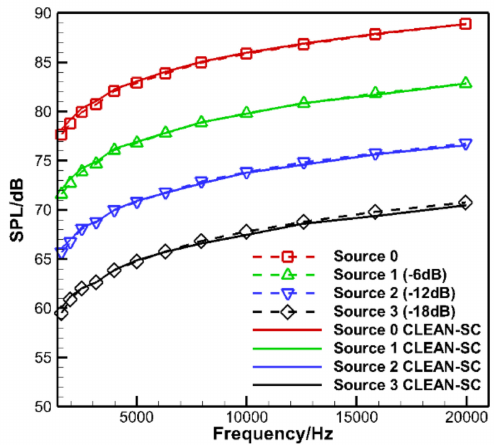
Figure 6. Comparison between the present results and the benchmark case for subcase